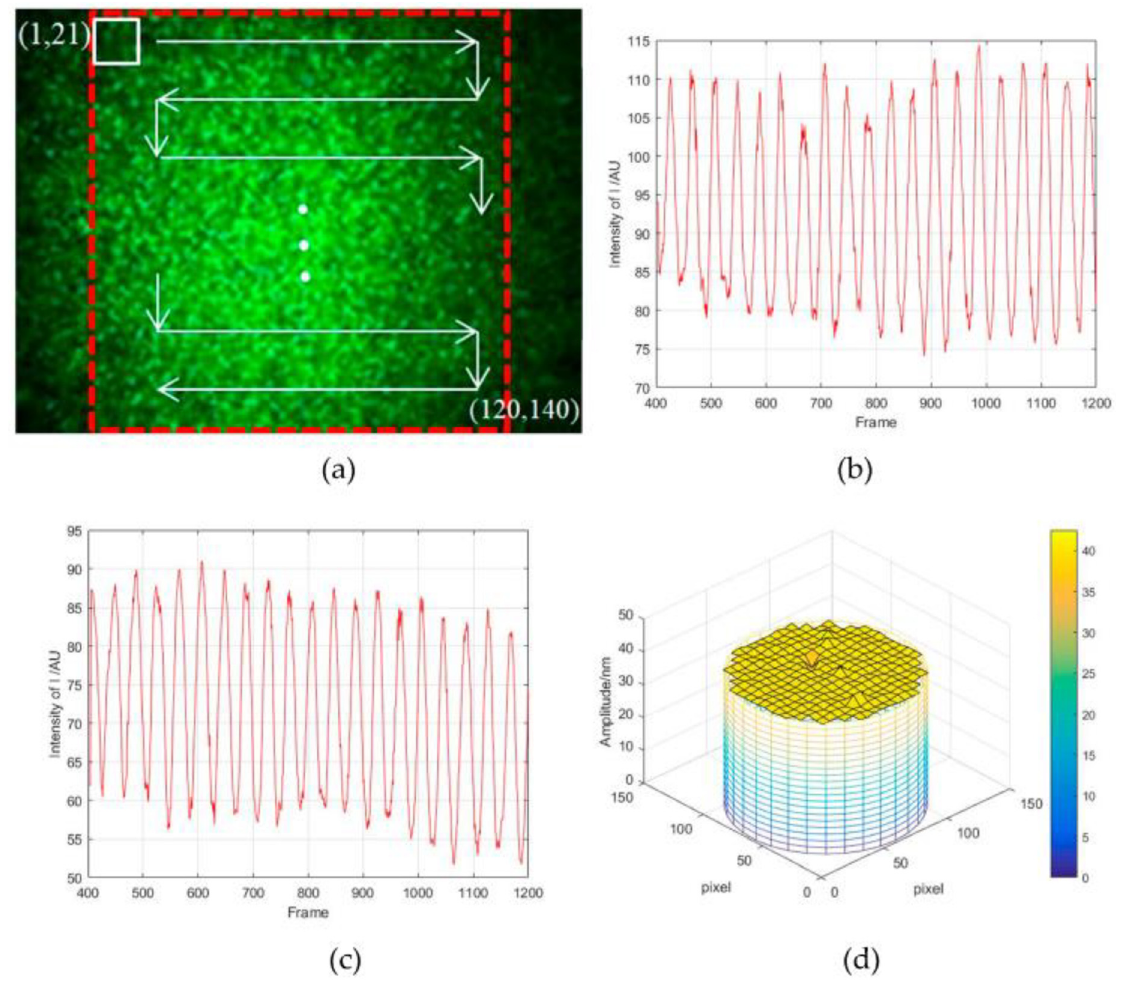
Figure 10. ( a ) The speckle image collected by CCD; ( b , c ) In the traversal process, the light intensity curves in two windows satisfying the orthogonal characteristics; ( d ) The surface distribution.